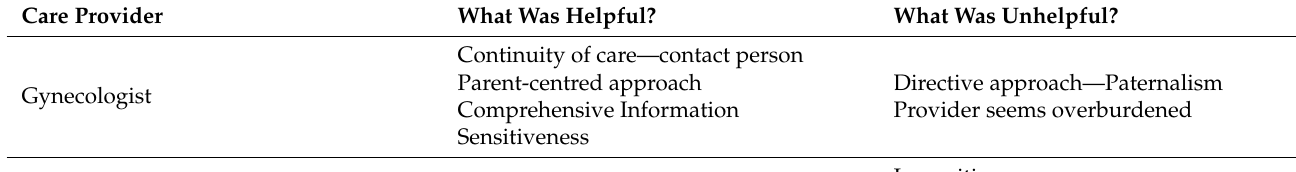
Table 3. Parental assessment of care